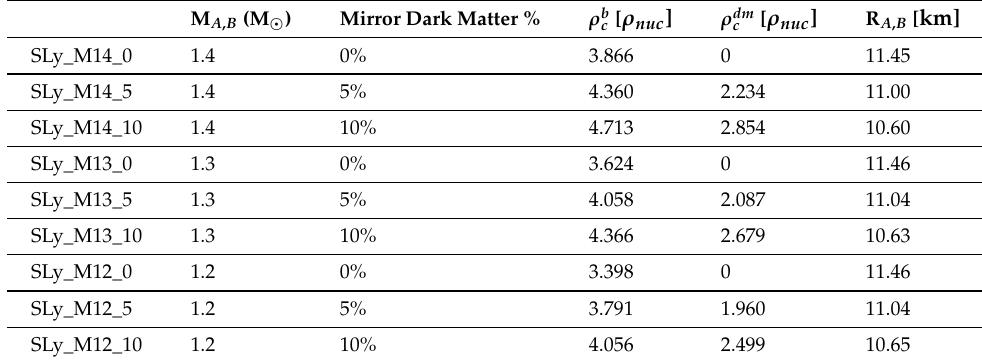
Table 2. Initial data for the mirror dark matter admixed binary neutron star simulations. The columns refer to the gravitational mass of each star, the dark matter percentage of the gravitational mass, the initial central density values for baryonic matter and dark matter respectively, and the total radius of the single stars. For the 1.4 M (cid:12) –1.4 M (cid:12) and 5% configuration, runs were performed for the four different resolution setups described in Section 3.2.